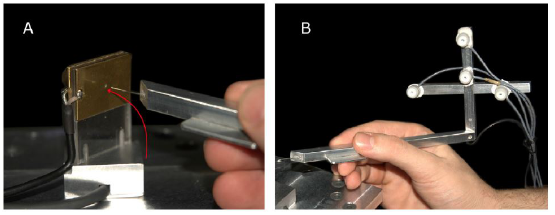
Figure 2. A) Participants in Valsecchi and Gegenfurtner (2015) tried to touch a small (1 mm) hole in a metal plate with a thin needle. The instructed movement is illustrated in red. B) Four ultrasound-emitting markers enabled motion tracking of the needle tip’s spatial position. From Valsecchi and Gegenfurtner